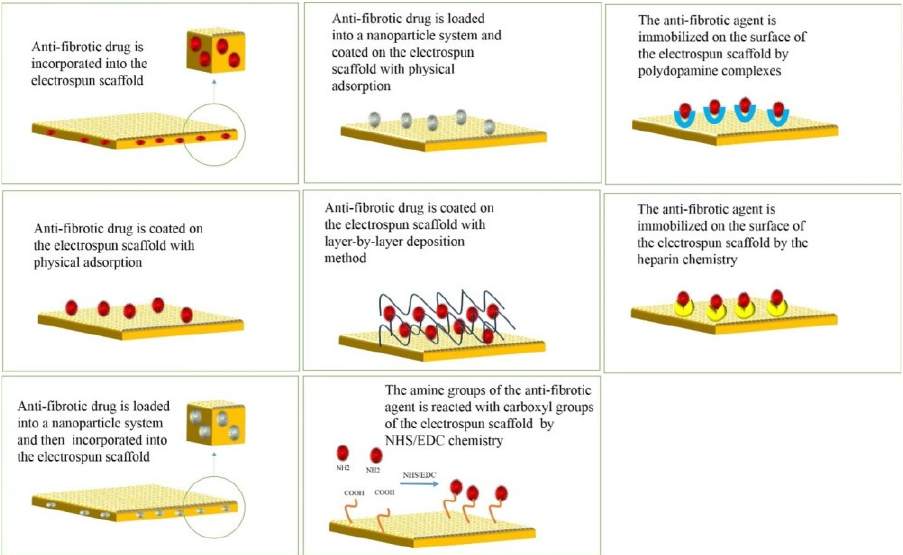
Figure 7. Schematic illustration representing the functionalization of electrospun scaffolds with var- ious drug loading technologies. various drug loading